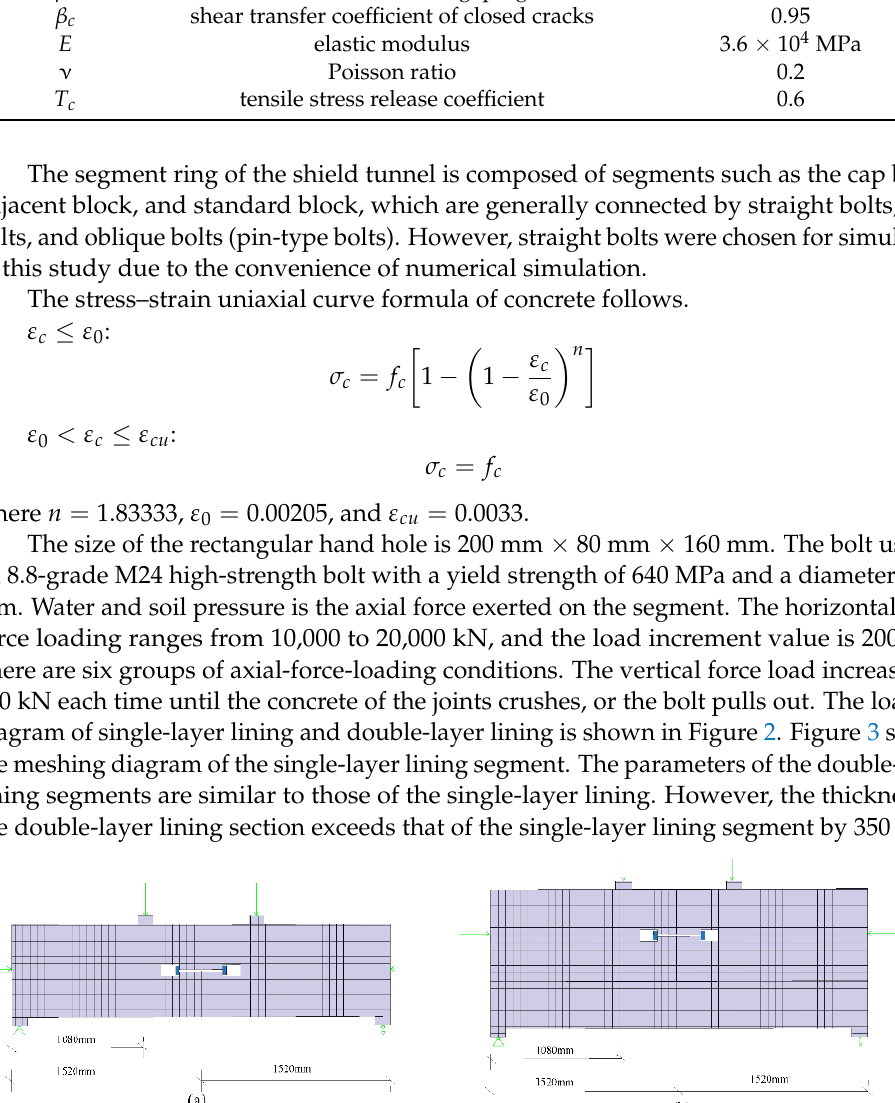
Figure 3. Meshing diagram of the single-layer lining segment. 2.2. Comparison of the Destruction Process Figure 4 shows the stress cloud of single-layer lining and double-layer lining seg- mental joints at the fifth and tenth load steps when the axial force is 10,000 kN. It can be seen that the single-layer lining and the double-lined segmental joint have a similar stress failure process. In other words, from the whole cross-section compression, the bolt is not under force; the compression area continues to move up, and the bolt participates in the force. At that time, the triangular stress zone appears in the lower part of the concrete under the tension of the bolt until the uppermost concrete reaches the yield compressive strength, or the stress concentration at the bolt hand hole exceeds the compressive strength of the concrete. Figure 5 shows the relationship between the stress of a node around the concrete compression zone and the loading time under the two lining modes.